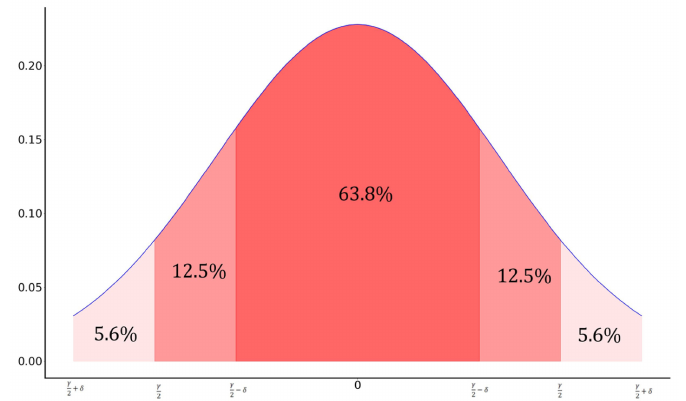
Figure 1. Curve of a one-dimensional Gaussian distribution